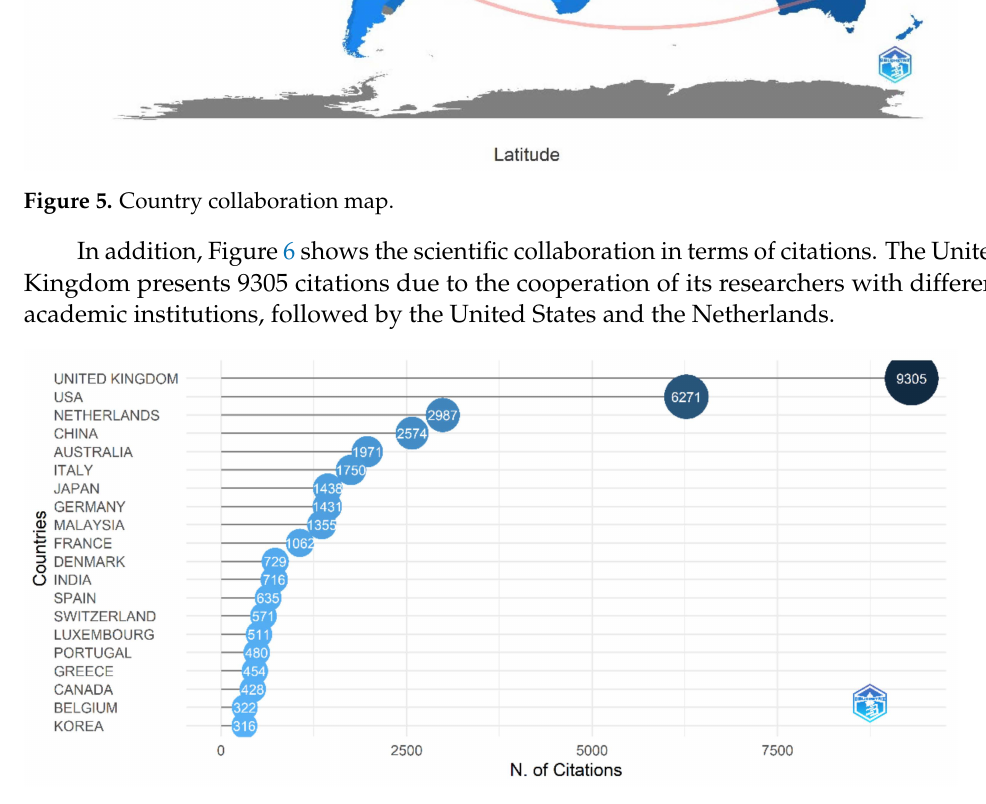
Figure 6. Top 20 countries by the number of citations.